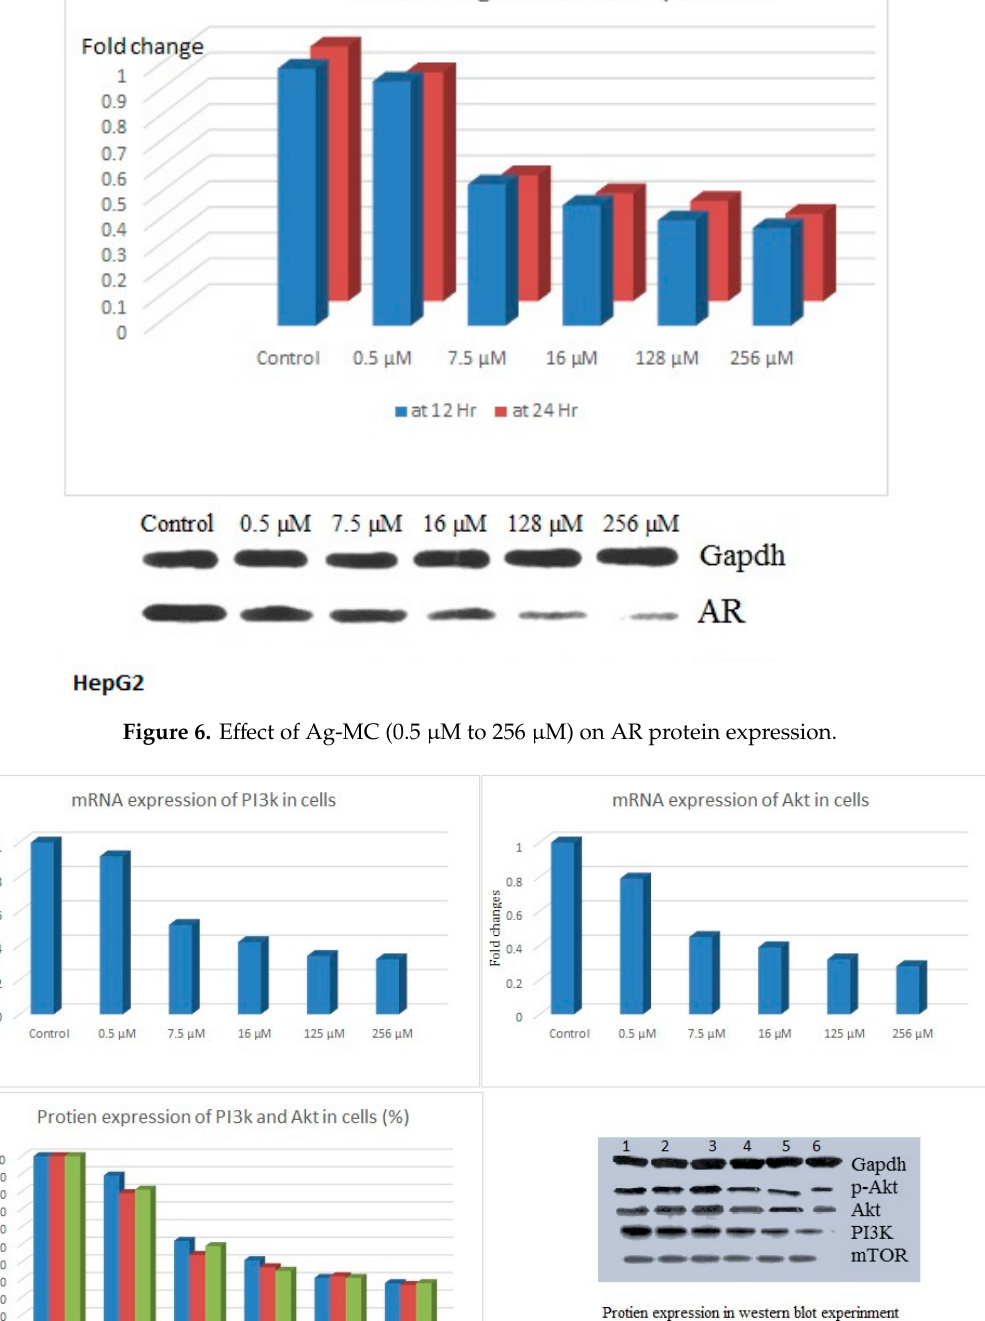
Figure 7. Effect of Ag-MC (lane 2-6) on mRNA and protein expression of MAPK signaling molecules.